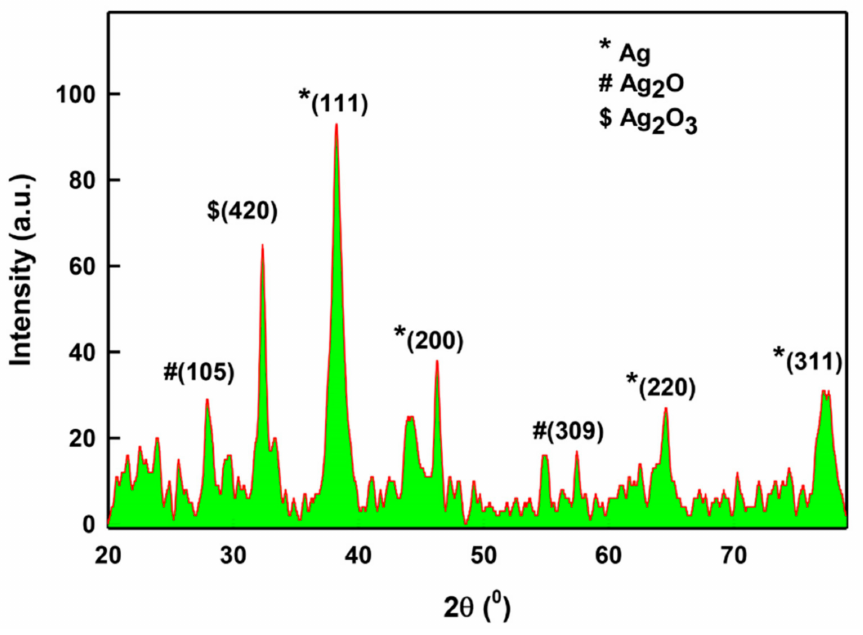
Figure 6. X-ray diffraction (XRD) pattern of